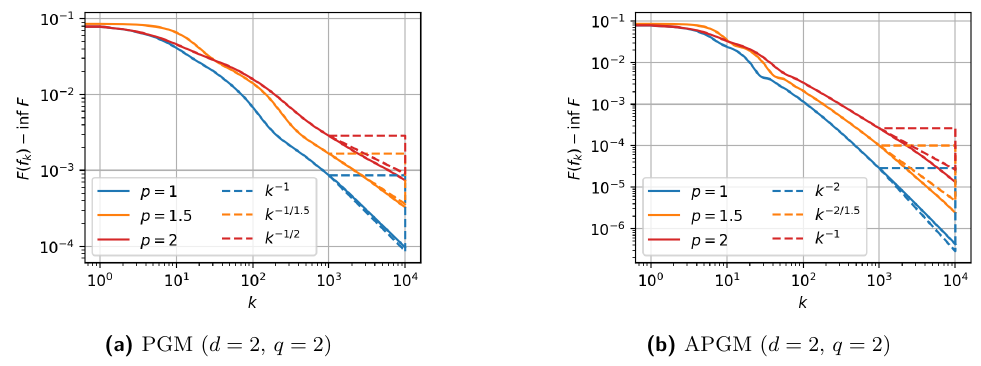
Figure 8 Convergence of PGM and APGM vs. theoretical rates (up to log factors) for a 2-layer ReLU neural network with H = λ ∥ µ ∥ and d = 1. Here p refers to the parameter of η p and p = 1 refers to η hyp . The objective has structure (I) so q = 1 in the rates of Table 2.